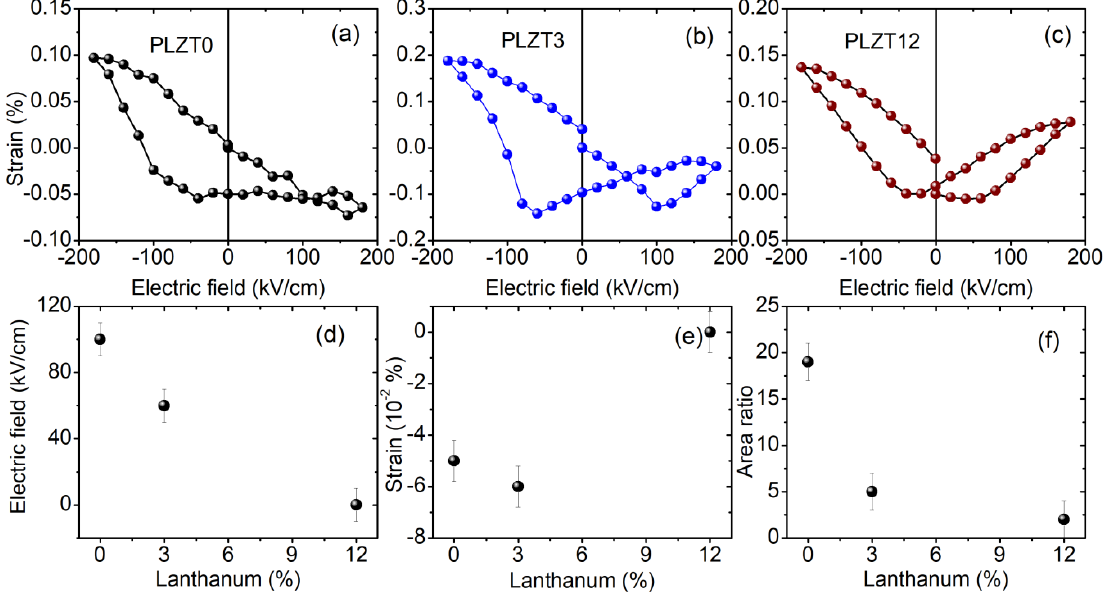
Figure 4. Piezoelectrically-induced strain inferred from the 2 θ -displacement of the center of mass of the PLZT 110 Bragg reflection for PLZT thin films shown in Figure 3, as a function of the applied voltage: ( a ) PLZT0, ( b ) PLZT3 and ( c ) PLZT12. ( d ) Electric field and ( e ) strain at which the two wings of the butterfly loops presented in parts (a), (b) and (c) cross each other as a function of the La concentration in the PLZT thin films. ( f ) Ratio of the areas of the left and right ‘wings’ of the butterfly loop, as a function of the La concentration.